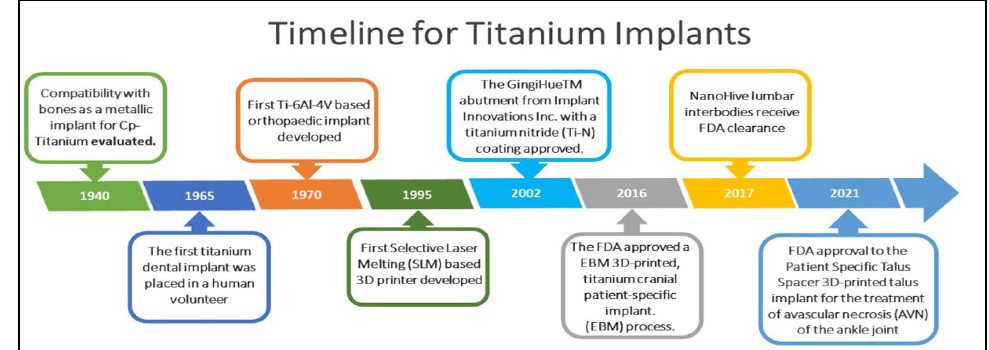
Figure 1. A brief history of the development of titanium implants for biomedical devices.